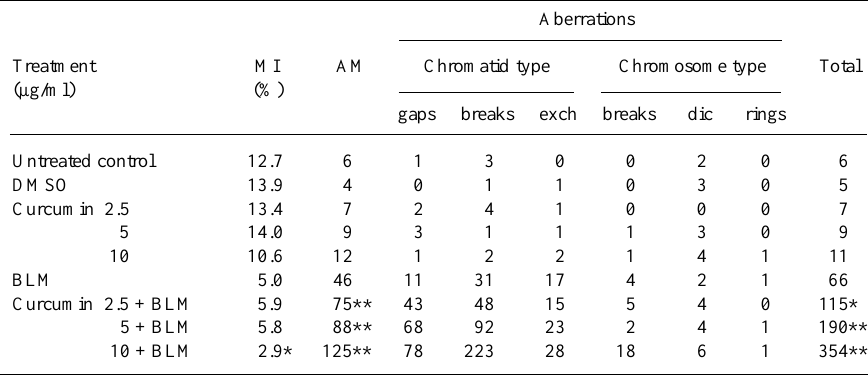
Table VI - Distribution of the different types of chromosomal aberrations in 300 cells analyzed per group of treatment and mitotic index y (MI) observed in CHO cells after treatment with curcumin (4 h) and/or bleomycin (BLM, 10 µg/ml) during G /S phase. 2 Aberrations Treatment